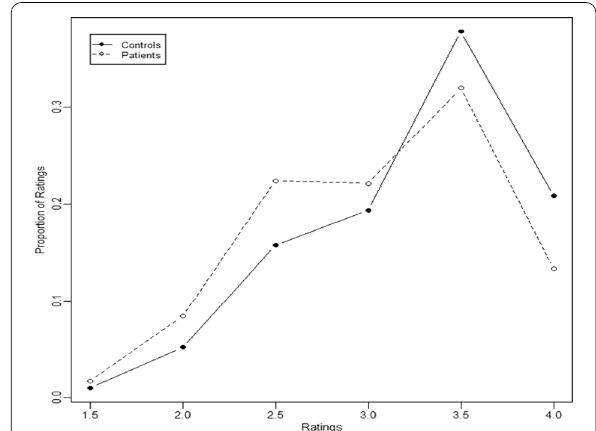
Fig. 3 Distributions of average reader ratings (after exclusion of pelvis MR